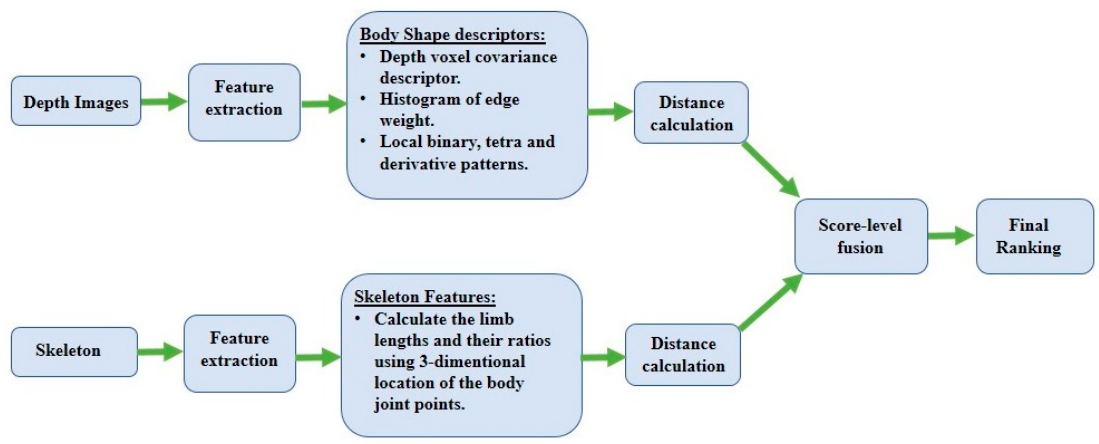
Figure 7. A flowchart of the depth–skeleton information-based Re-ID framework.